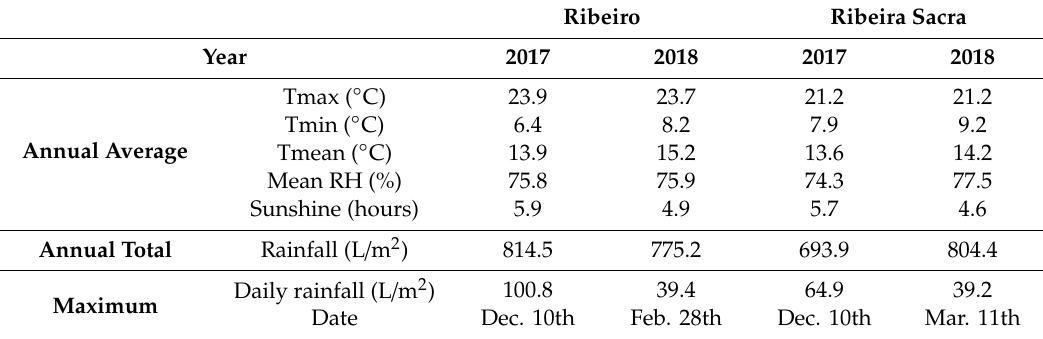
Table 1. Annual values of the main meteorological variables considered for both wine-growing regions, Ribeiro and Ribeira Sacra in 2017 and